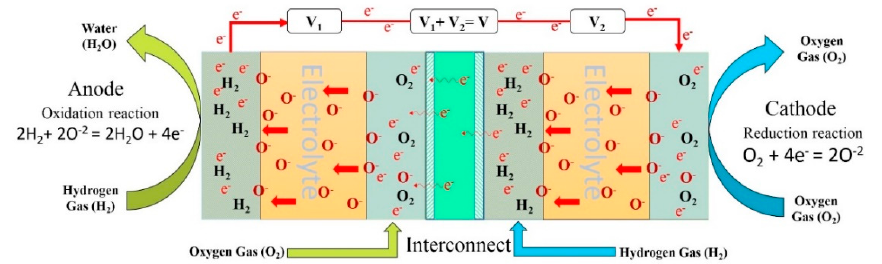
Figure 1. Block diagram of Solid Oxide Fuel Cell and gasses